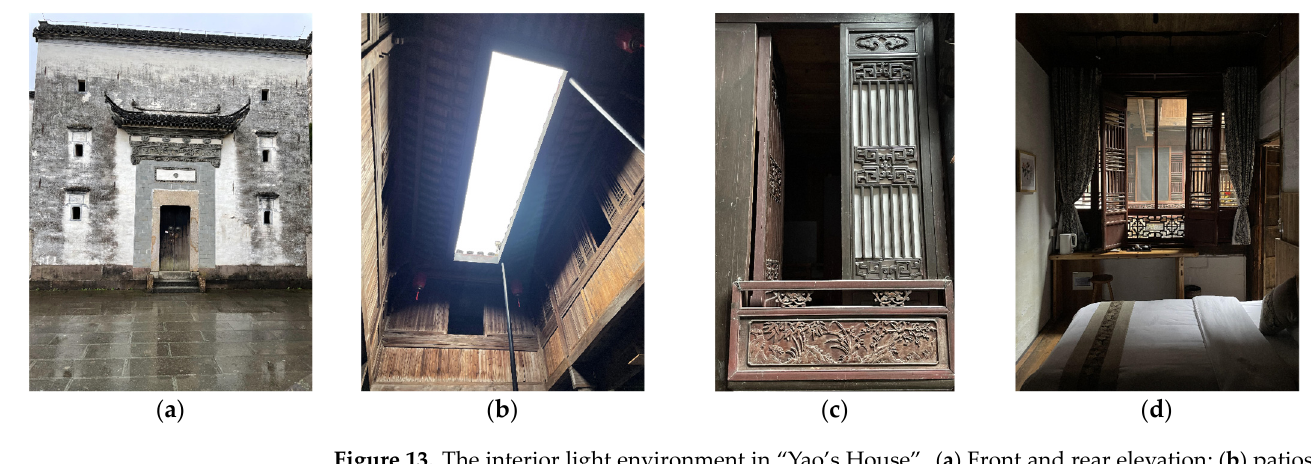
Figure 13. The interior light environment in “Yao’s House”. ( a ) Front and rear elevation; ( b ) patios; ( c ) windows; and ( d ) bedroom.